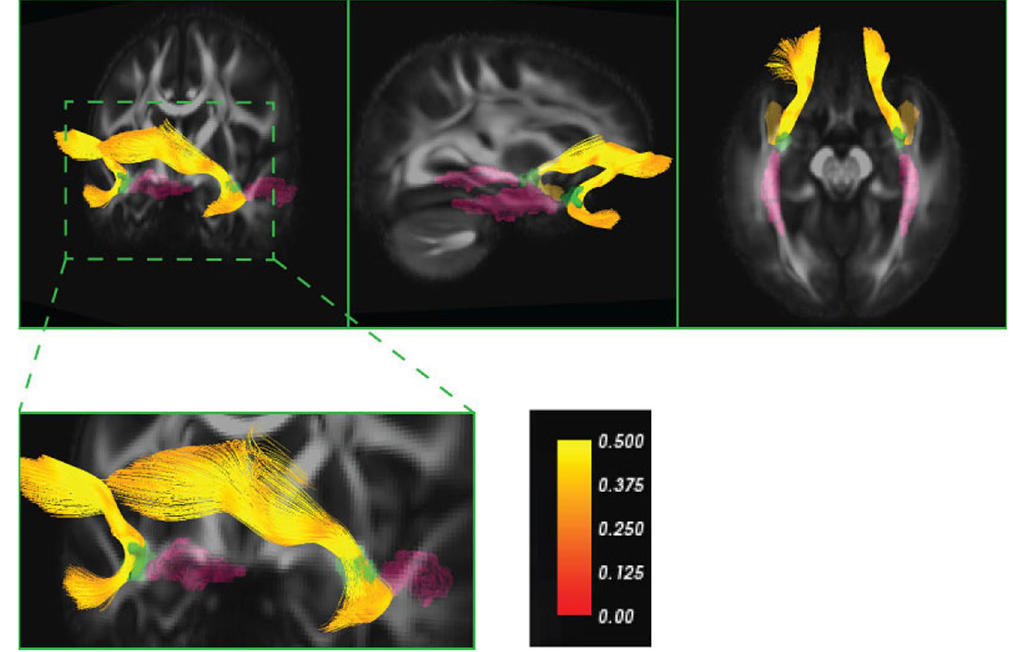
Figure 1. JHU ICBM atlas of uncinate fasciculus (UF) and sagittal stratum regions of interest are illustrated in green and pink, respectively. To better illustrate the relative anatomical location of JHU UF, deterministic tractography of UF is shown in yellow. The figure shows that UF tractography passes through JHU ROI, which corresponds to the intermediary segment of the UF between frontal and anterior temporal